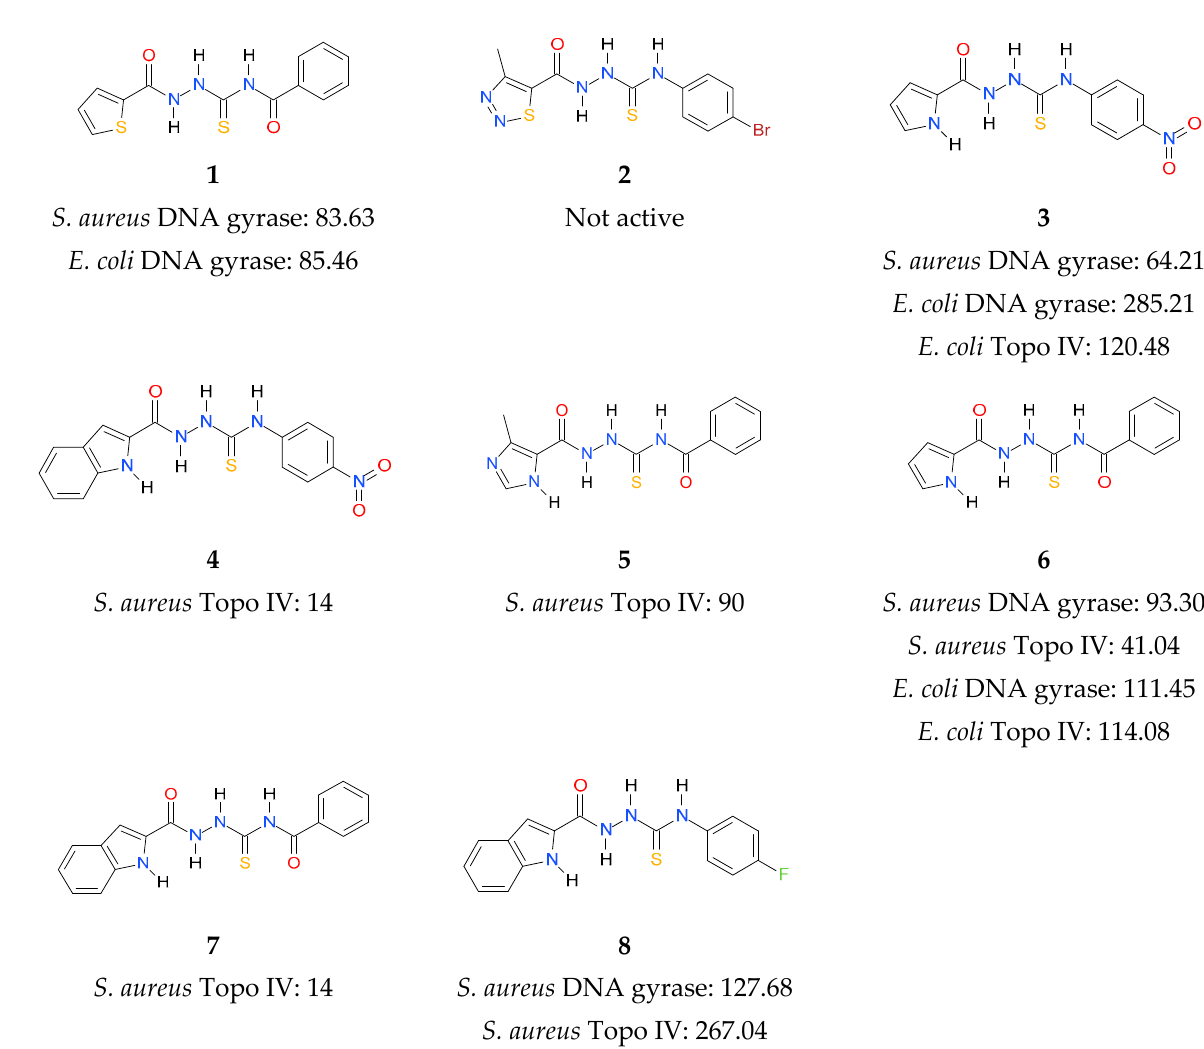
Figure 1. Inhibitory activity (IC 50 , ( µ M)) of thiosemicarbazide derivatives 1 – 8 against bacterial DNA topoisomerases [37–39]. Gyrases were tested for their supercoiling activity using relaxed pBR322 as a substrate, while Topo IV compounds were tested for their decatenation activity using kDNA.